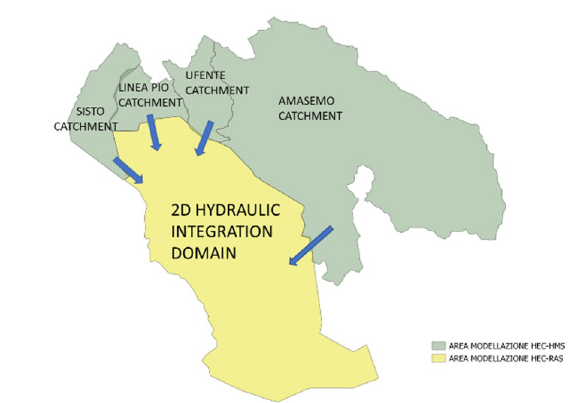
Figure 5. Sketch of integration